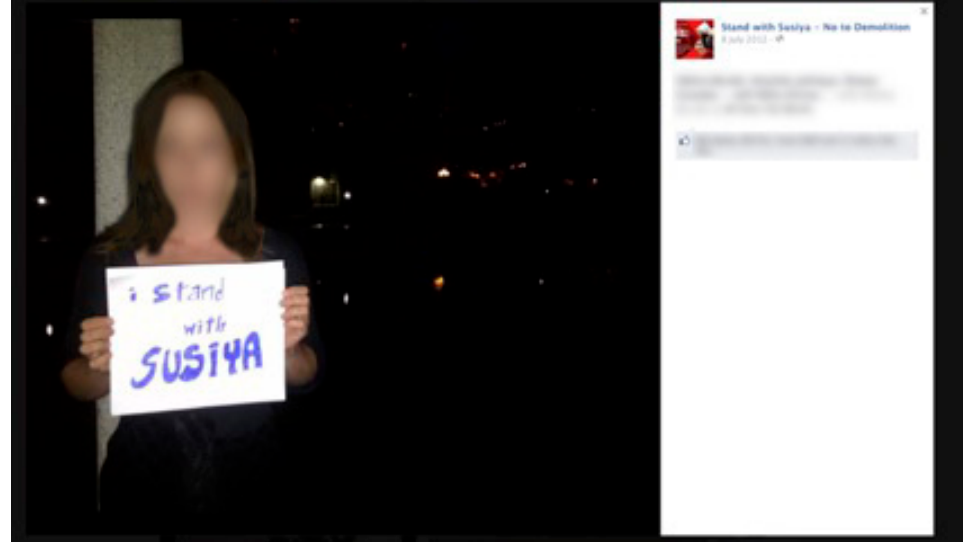
Figure 5. Example of the selfie communication used for a social media profile. Screen grab from the Stand with Susiya—No to Demolition Facebook gallery (Accessed on 12 July 2012).